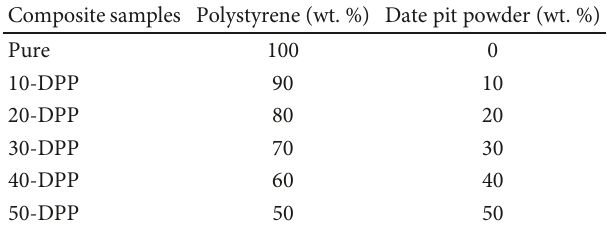
Table 1: Samples abbreviation. Composite samples Polystyrene (wt. %) Date pit powder (wt.